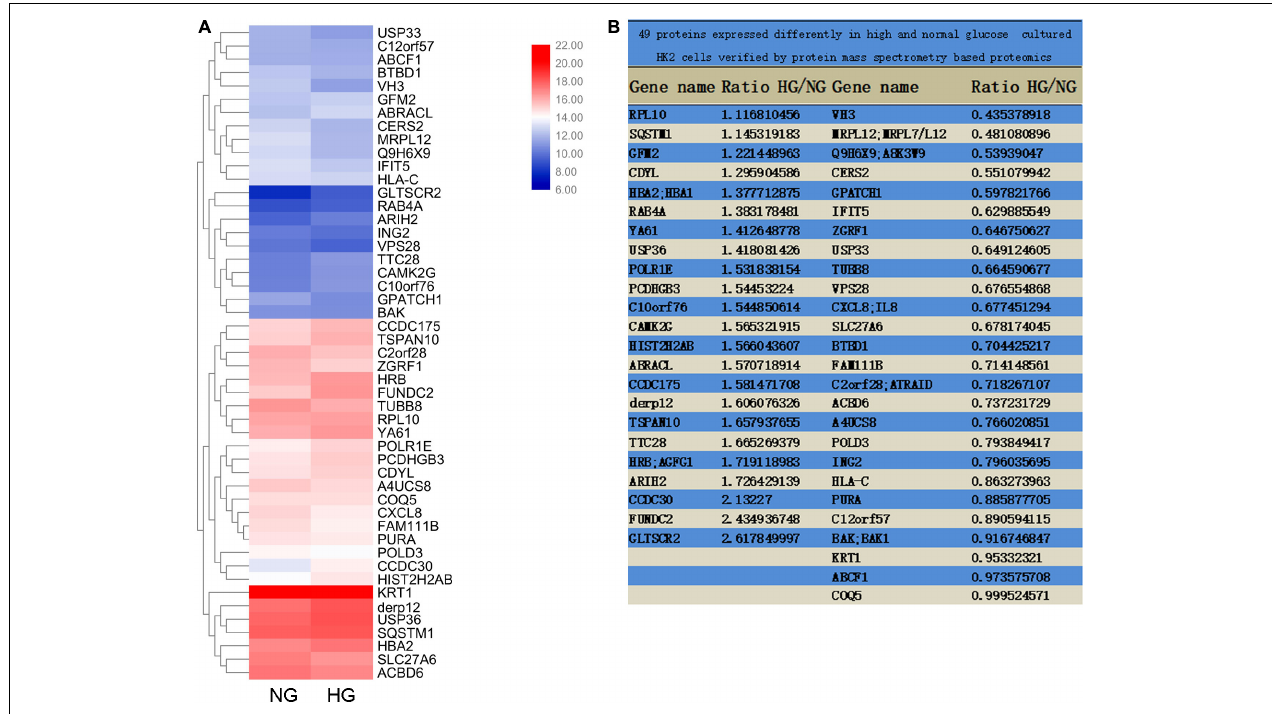
FIGURE 1 | Mass Spectrometry-Based Proteomics. (A) The heatmap of M-S analysis. Compared with the 5 mM (normal glucose, NG) group, the expression of 49 proteins in 25.5 mM (high glucose, HG) group was significantly different. (B) The proportion of 49 protein expression in HG and